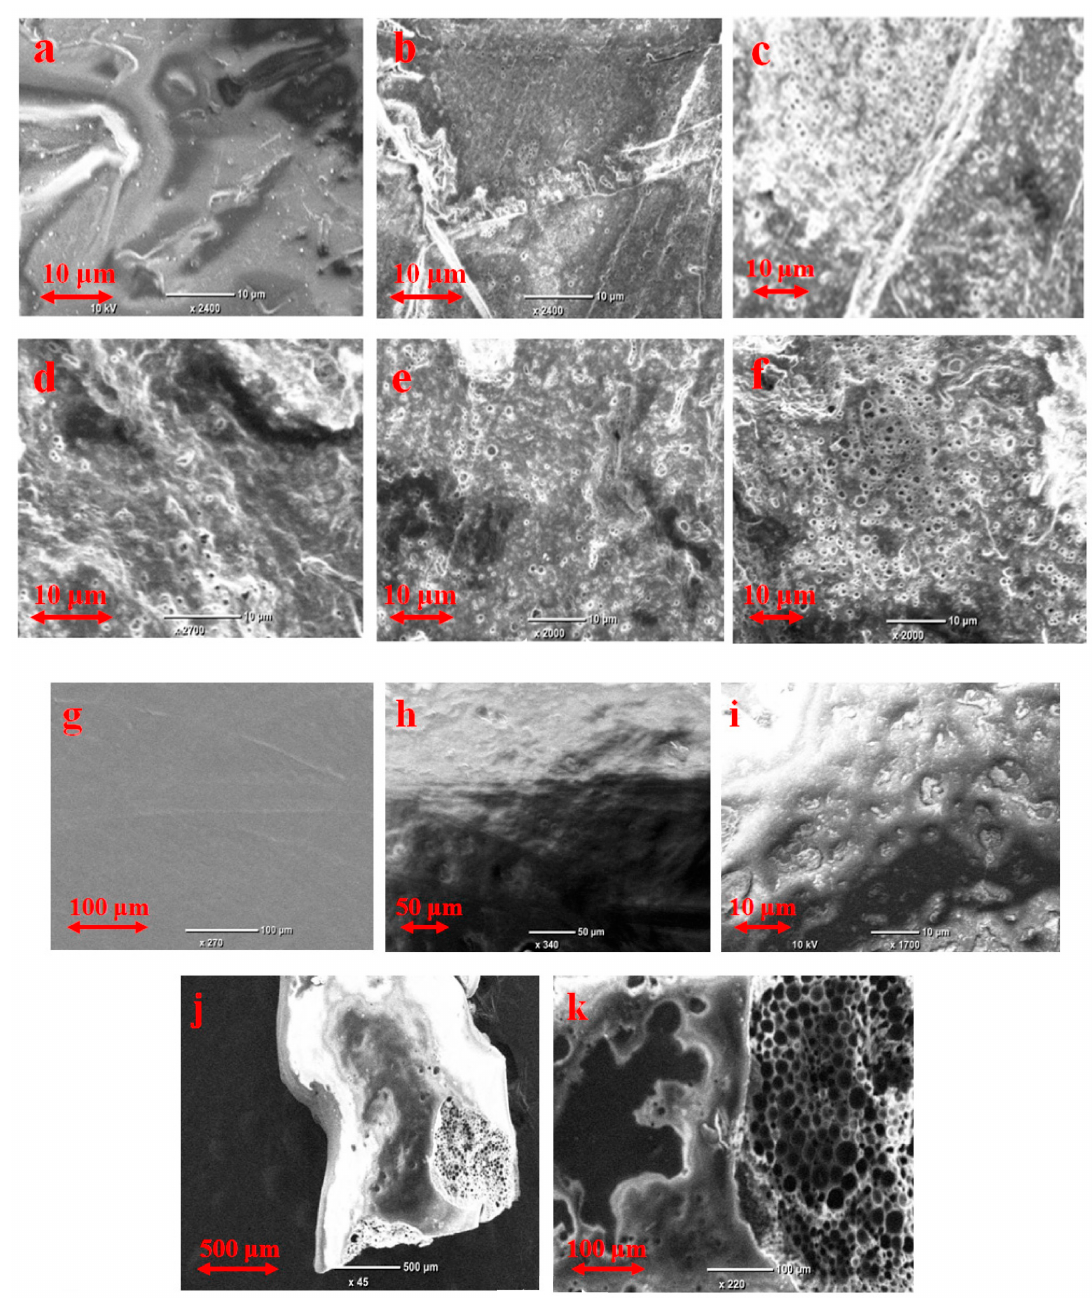
Figure 11. SEM microphotographs of PDL 02 ( a–f ) and PDL 04 ( g–k ) films recorded after different time of keeping them in PBS: ( a ) — dry film, ( b ) — 2 h, ( c ) — 4 days, ( d ) — 6 days, ( e ) — 9 days, ( f ) — 11 days, ( g ) — 1 day, ( h ) — 5 days, ( i ) — 90 days, and ( j , k ) — 101 days.